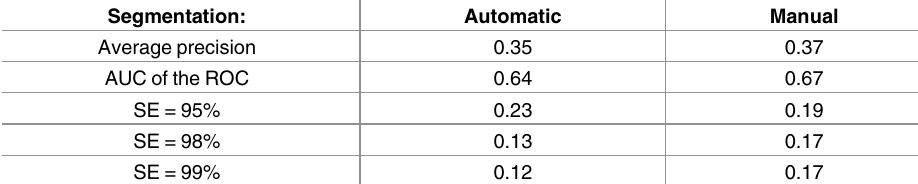
Table 2. Scores for Nevus Doctor.